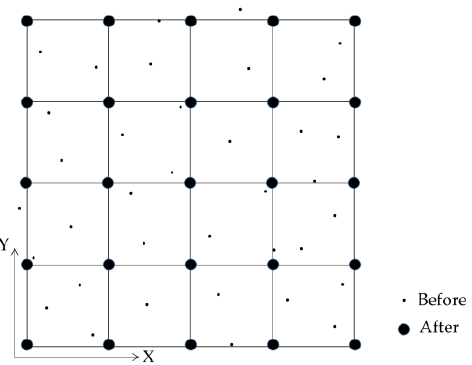
Figure 2. Regular square mesh interpolation.